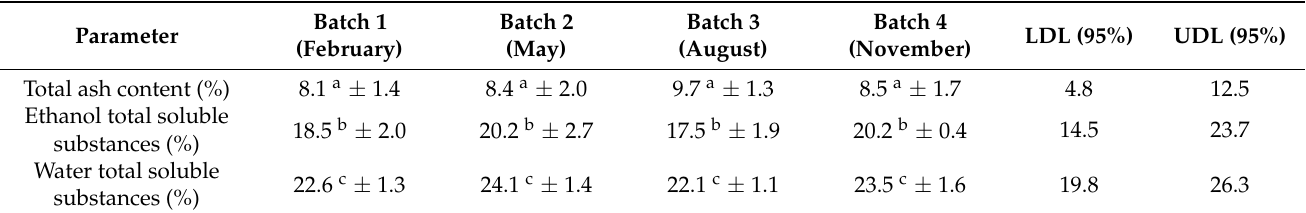
Table 1. Quantitative quality control parameters of dried leaves from Plectranthus neochilus collected in Santiago de Cuba at different times.